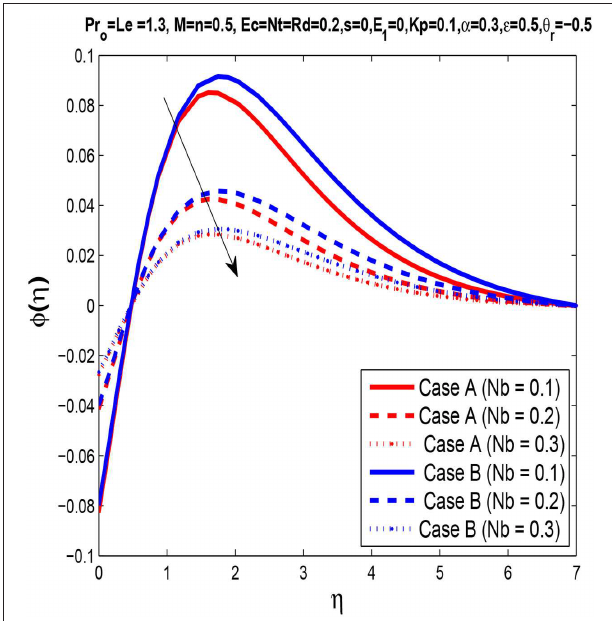
FIGURE 10 | Concentration profile φ ( η ) for different values of Nb .